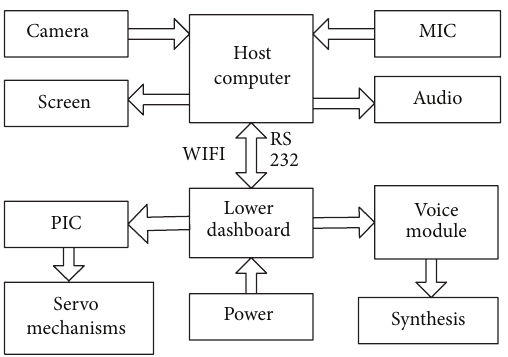
Figure 3: Robot motor control